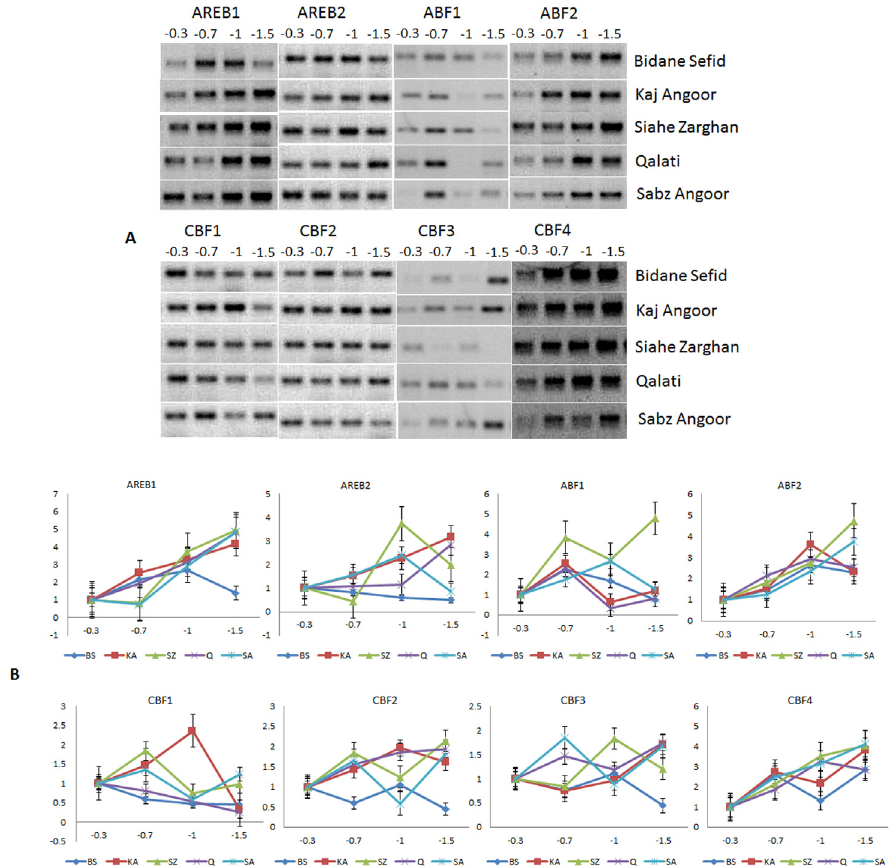
Fig 1. Semiquantitative (A) and Quantitative (B) expression analysis of AREB/ABF and DREB/CBF genes in the leaf tissues of five different varieties of grape under drought